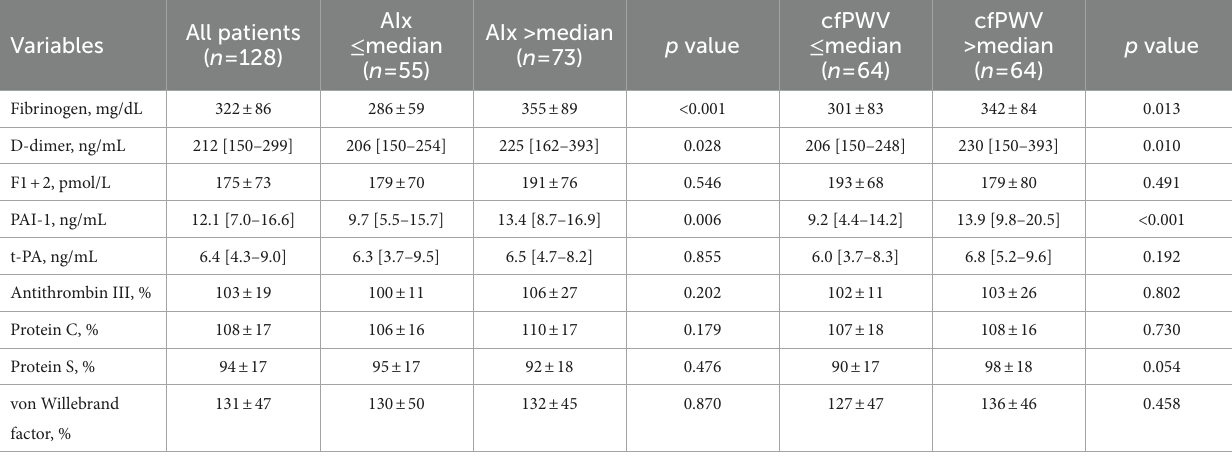
TABLE 3 Hemostatic variables of hypertensive patients who were grouped according to the median value of the Augmentation Index (AIx) and carotid- femoral pulse wave velocity (cfPWV).